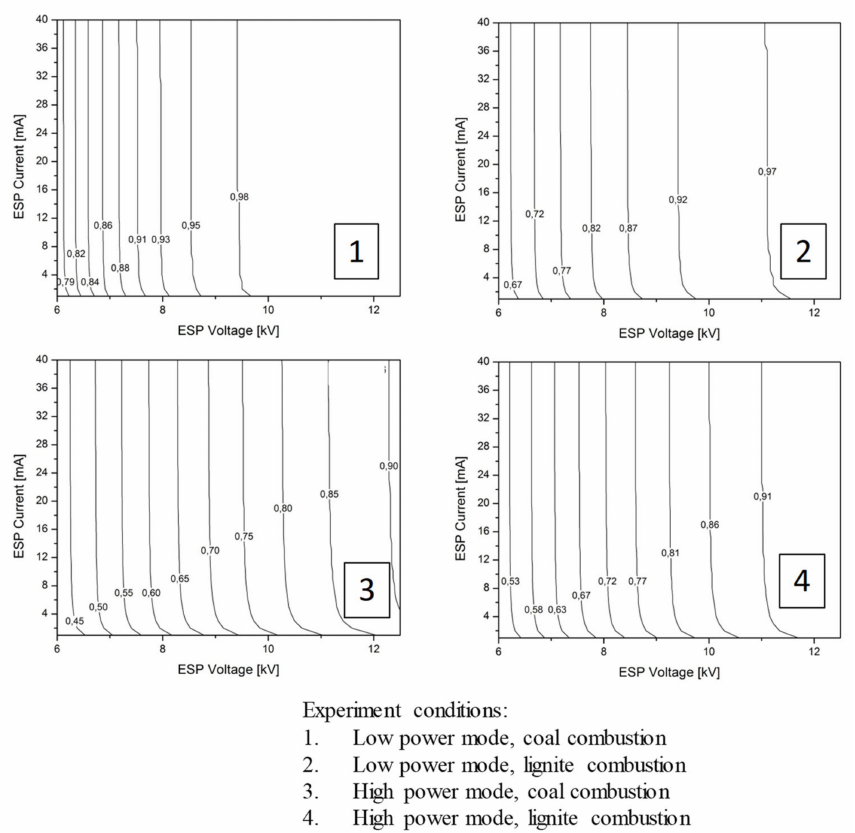
Figure 4. Expected and obtained precipitation efficiency depended on ESP electric